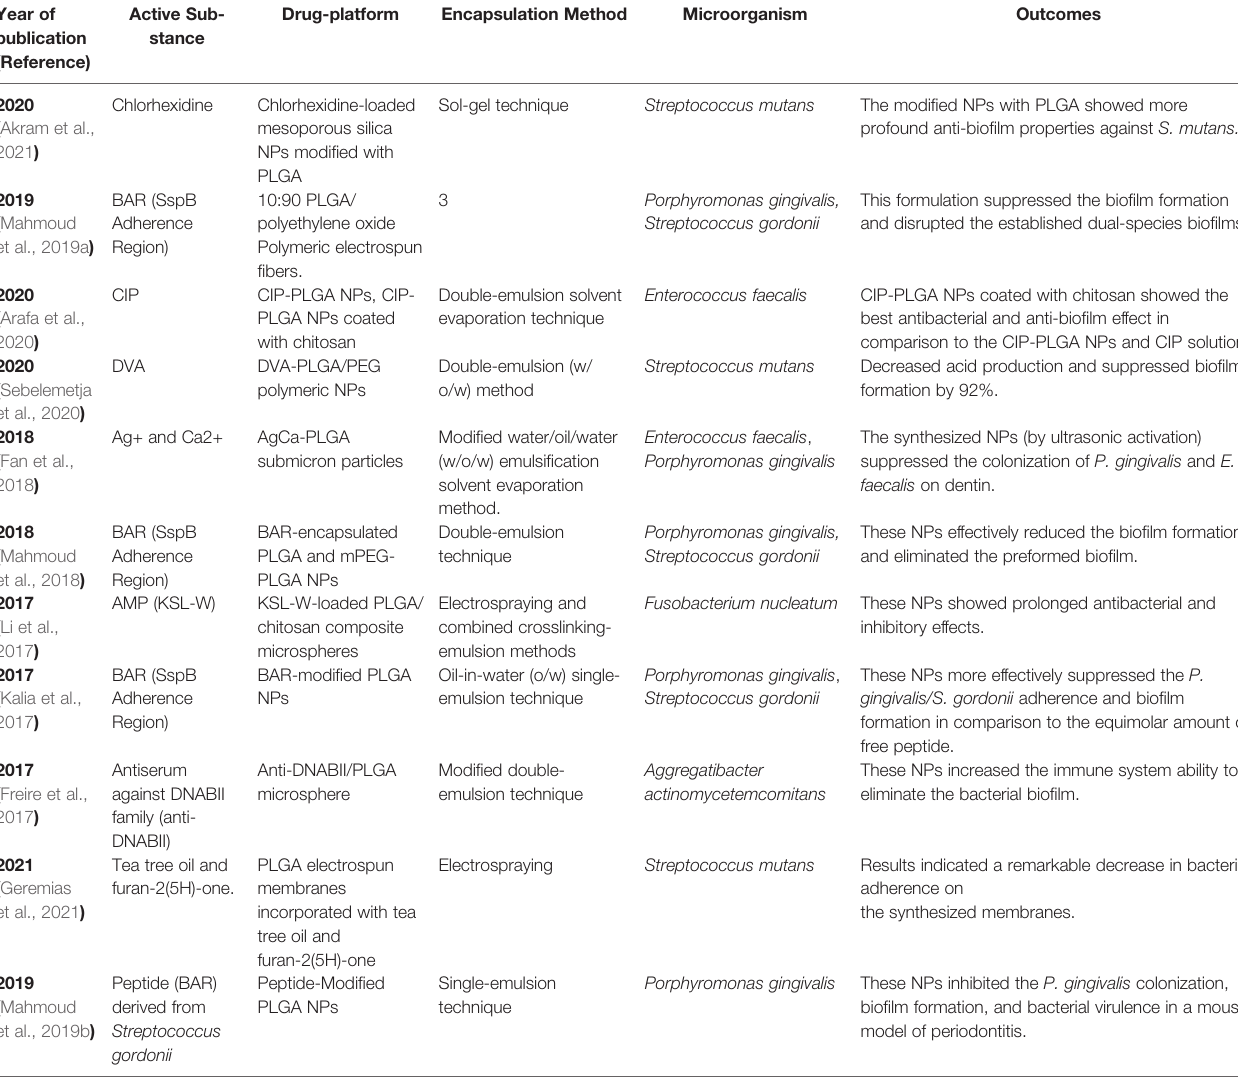
TABLE 2 | Different PLGA NPFs that have been used for inhibition of bacterial bio fi lm-associated oral